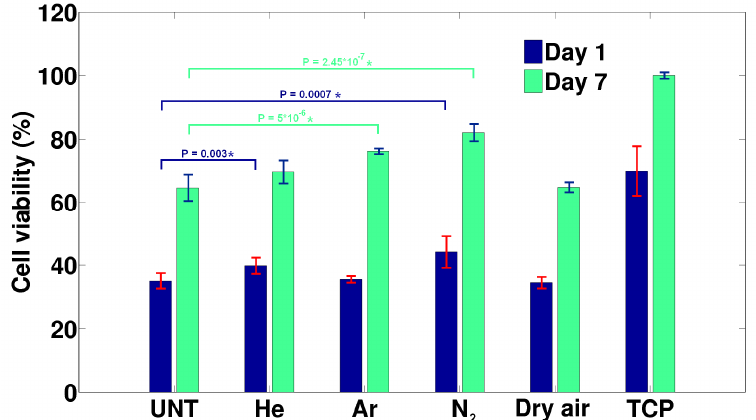
Figure 4. Human foreskin fibroblast (HFF) cell viability 1 and 7 days after seeding for the different treatments (Ar: 11.3 J/cm 2 ; He: 22.6 J/cm 2 ; N 2 : 45.2 J/cm 2 and Dry air: 45.2 J/cm 2 ) relative to tissue culture plates (TCPs). Samples marked with an * are significantly different with a 99% certainty.